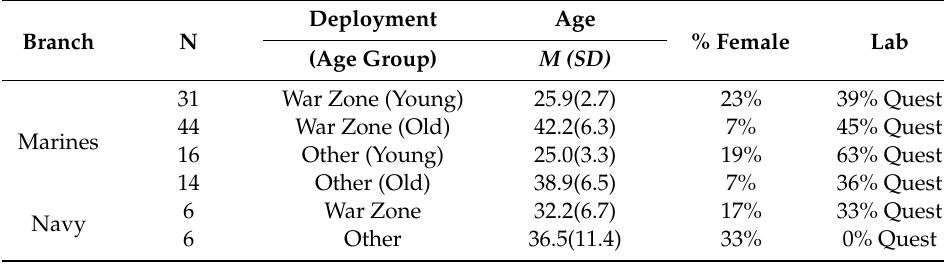
Table A1. Participant characteristics in each of the